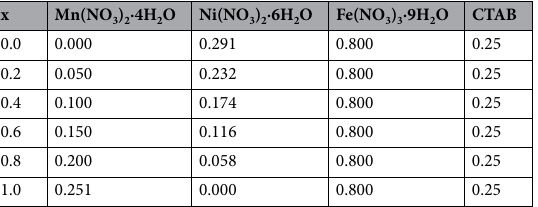
Table 1. Amounts (g) of the precursors to synthesize Ni x−1 Mn x Fe 2 O 4 nanoparticles.